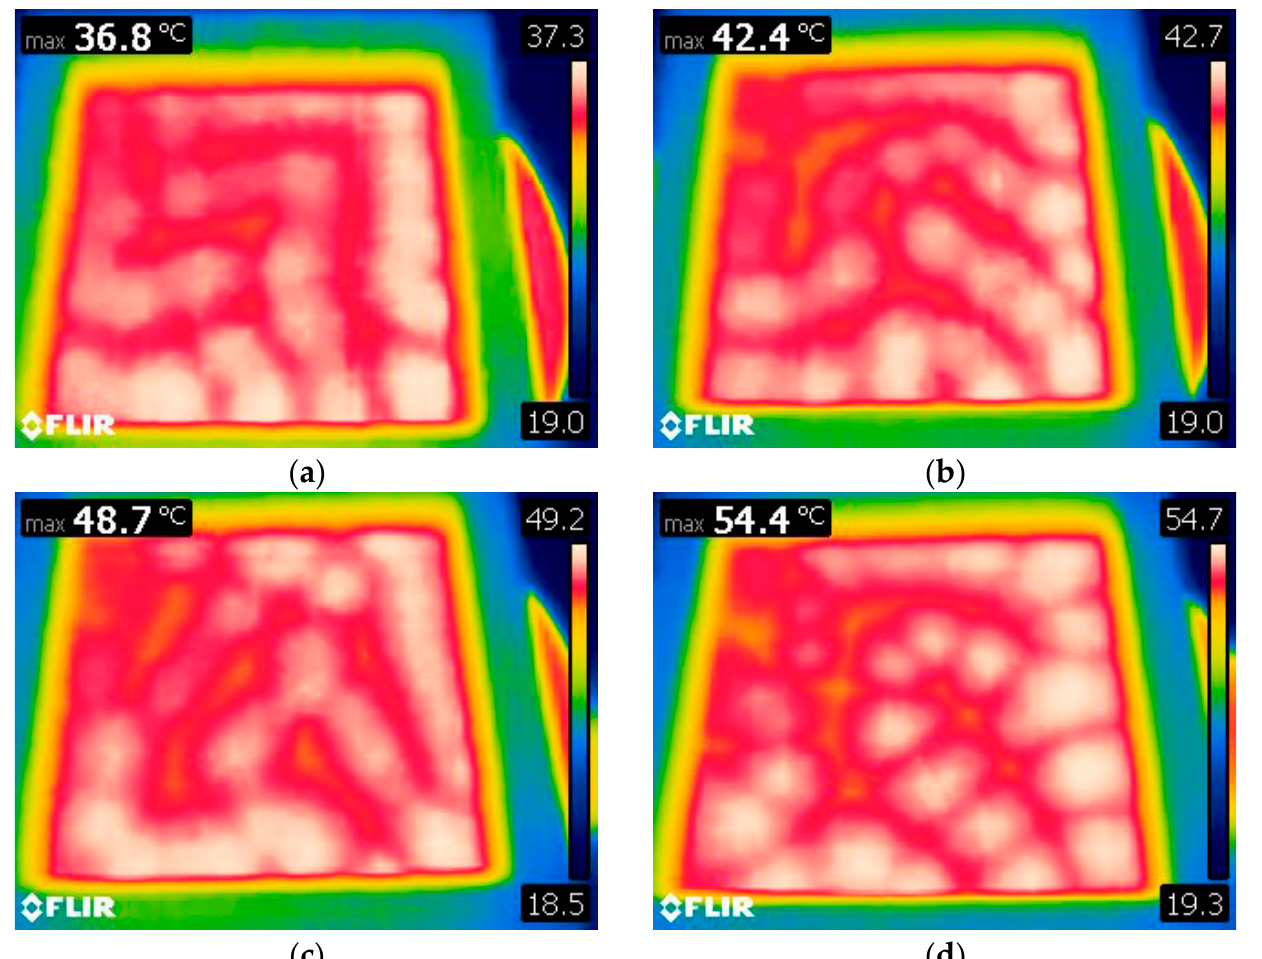
Figure 4. Surface temperature distribution for d = 0.50 cm ( Ω = 32 mL) and no inclination ( A = 16, Bo dyn ≅ 0.86, Ra ≅ 2.5 × 10 2 × ∆ T , Ma ≅ 2.94 × 10 2 × ∆ T ): ( a ) ∆ T = 13 °C, ( b ) ∆ T = 18 °C, ( c ) ∆ T = 21 °C, ( d ) ∆ T = 27 °C.